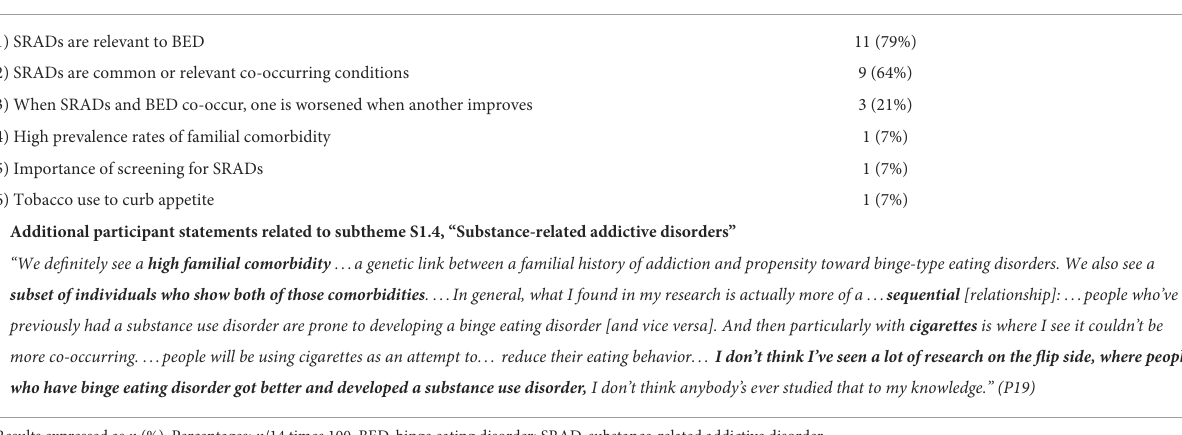
TABLE 7 Participant statements relating to domain 4, “substance-related addictive